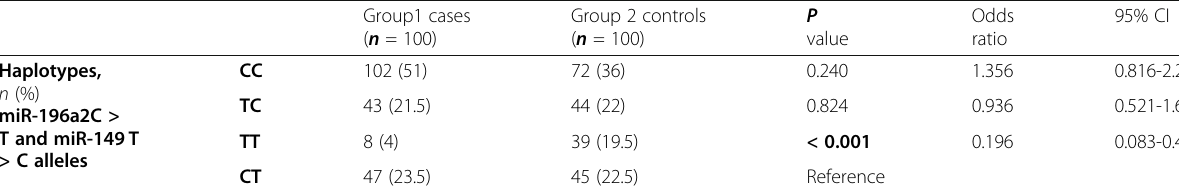
Table 4 Haplotypes analysis of miR-196a2T > C and miR-149 T > C